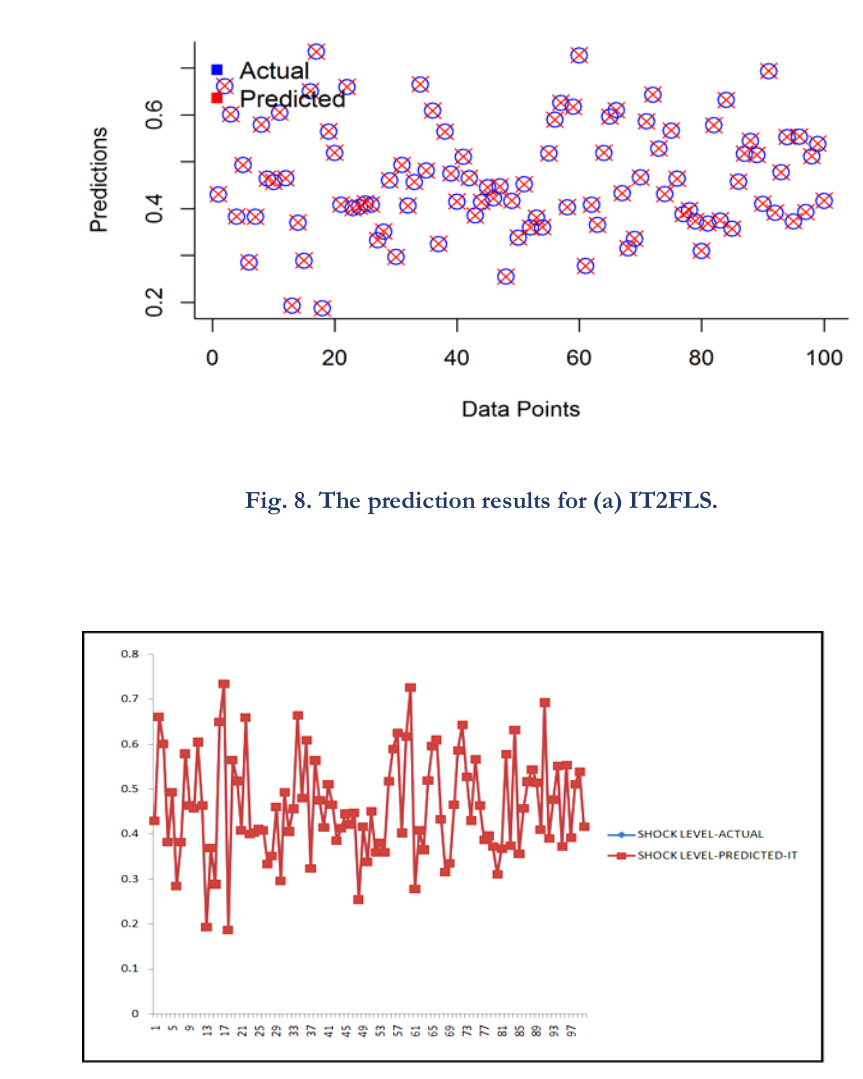
Fig. 9. System’s response of the IT2FLS for the actual and predicted shock